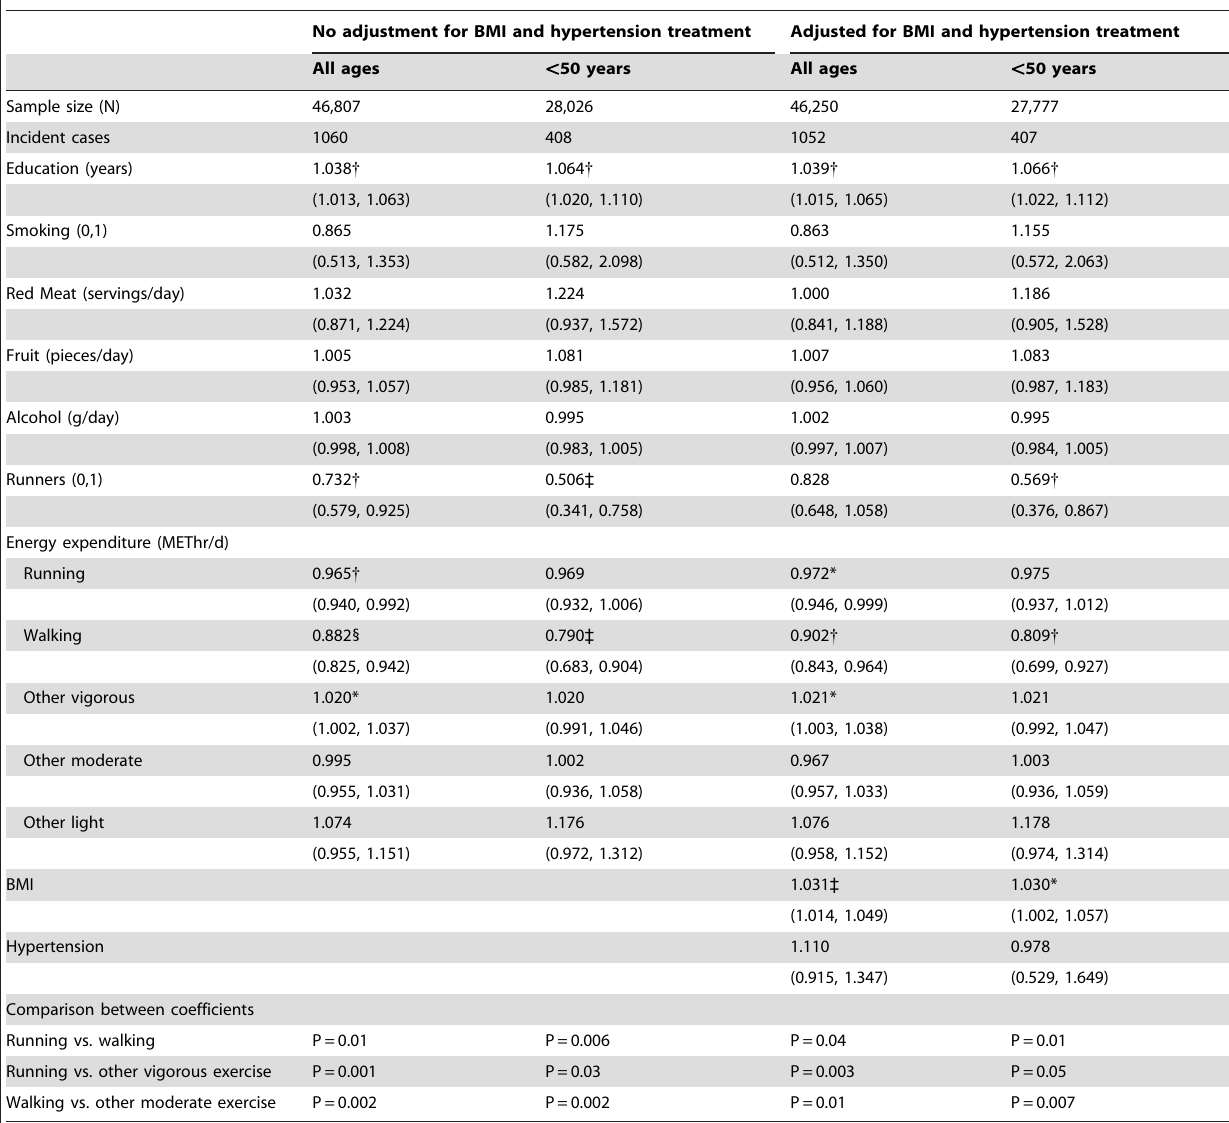
Table 2. Hazard ratios (95% confidence intervals) of incident self-reported physician- diagnosed cardiac arrhythmias vs. exercise energy expenditure during 6.2-year